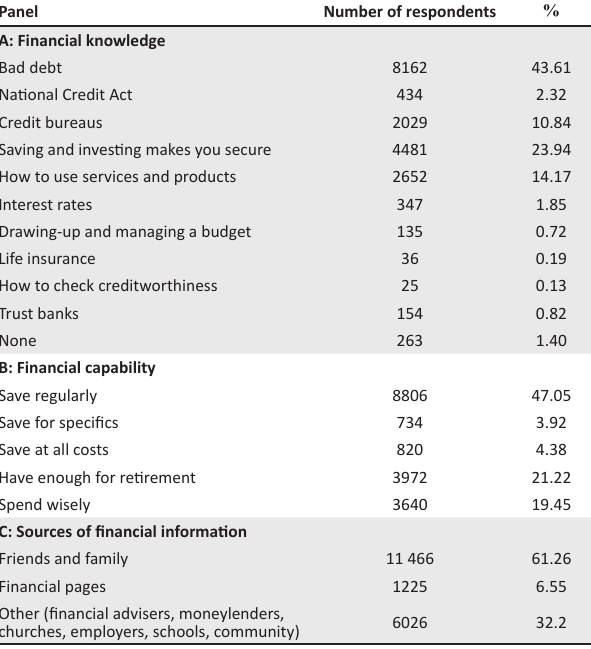
TABLE 2: Positive responses for financial literacy domain questions. Panel